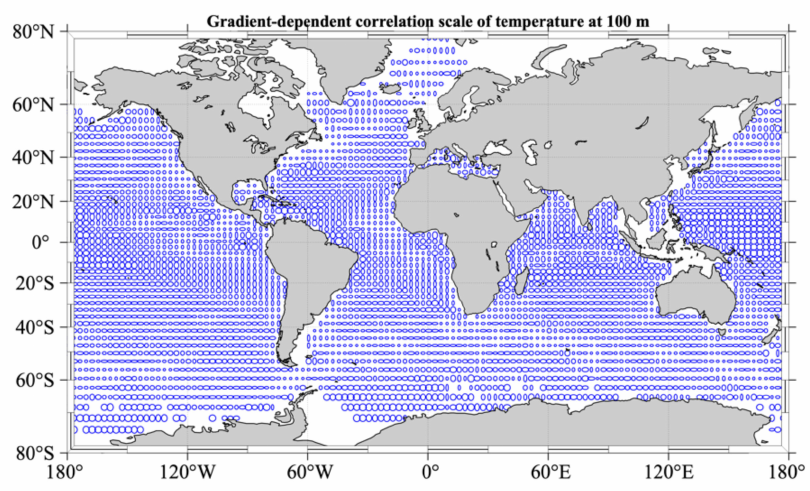
Figure 2. The distribution of the temperature correlation scales at a depth of 100